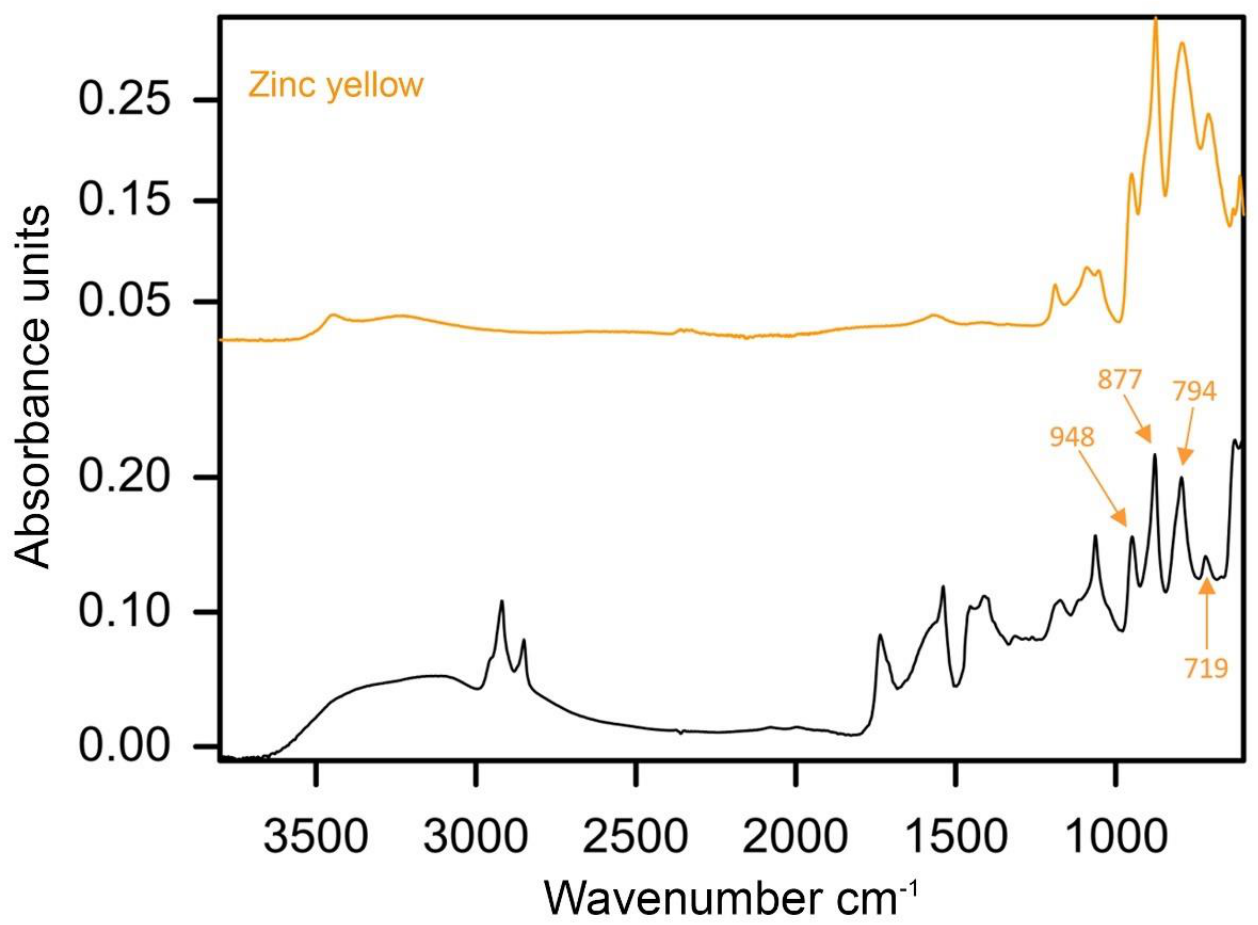
Figure 15. ATR – FTIR spectra of the green paint of sample 1 extracted from Mountain (1977), with labelled marker peaks of zinc yellow admixture and reference spectra of the same pigment.